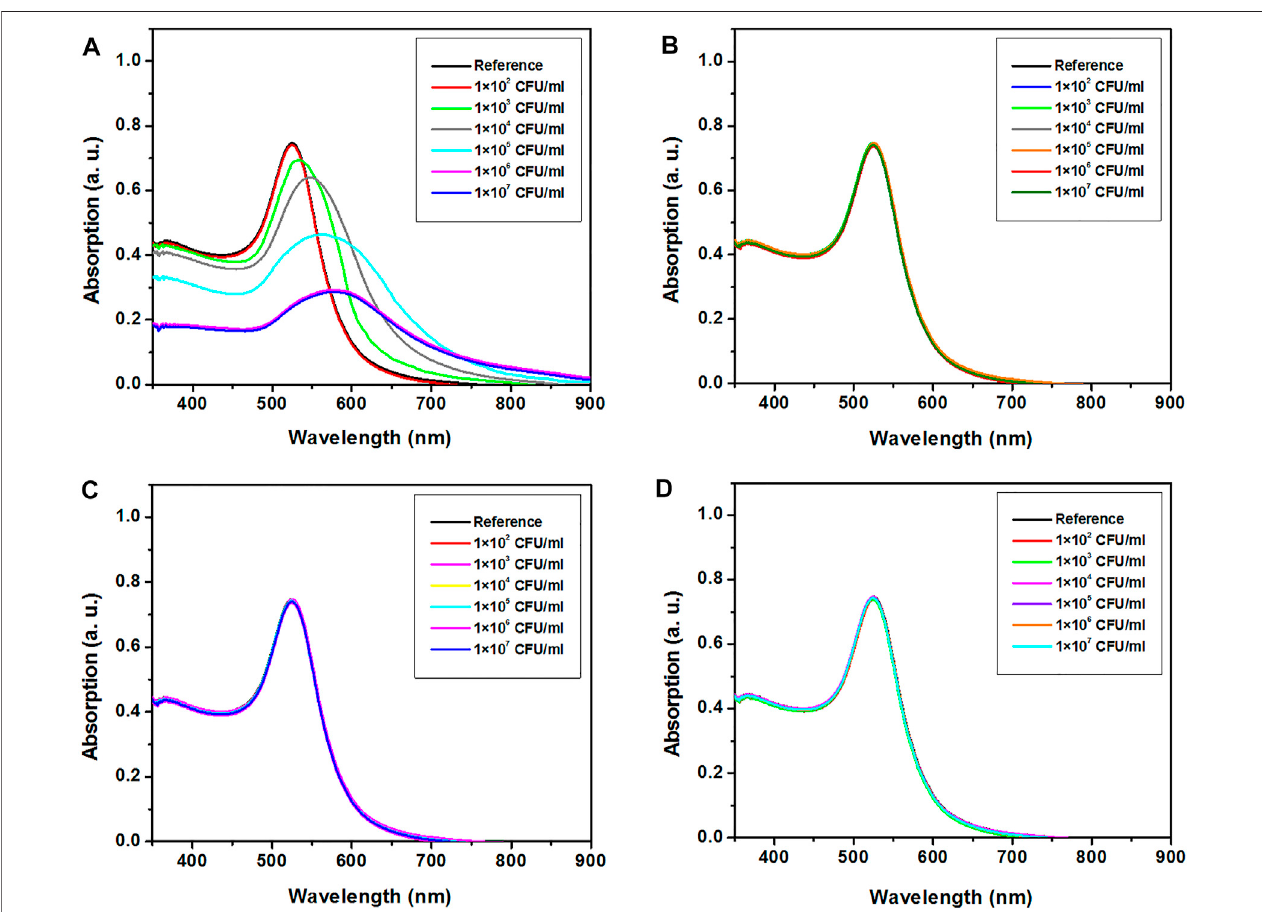
FIGURE5 | UV – visible absorption spectra of H-1-AuNPs before and after adding saliva samples infected withM1 GAS (A) , M6 GAS (B) , M12 GAS (C) , and E. coli O157:H7 (D) at concentrations of 1×10 2 , 1×10 3 , 1×10 4 , 1×10 5 , 1×10 6 , and 1 × 10 7 CFU/ml. Reference (H-1-AuNPs containing uninfected saliva sample). H-1-AuNPs could detect M1 GAS in a concentration range of 1 × 10 3 – 1×10 6 CFU/ml based on the value of red-shift in SPR